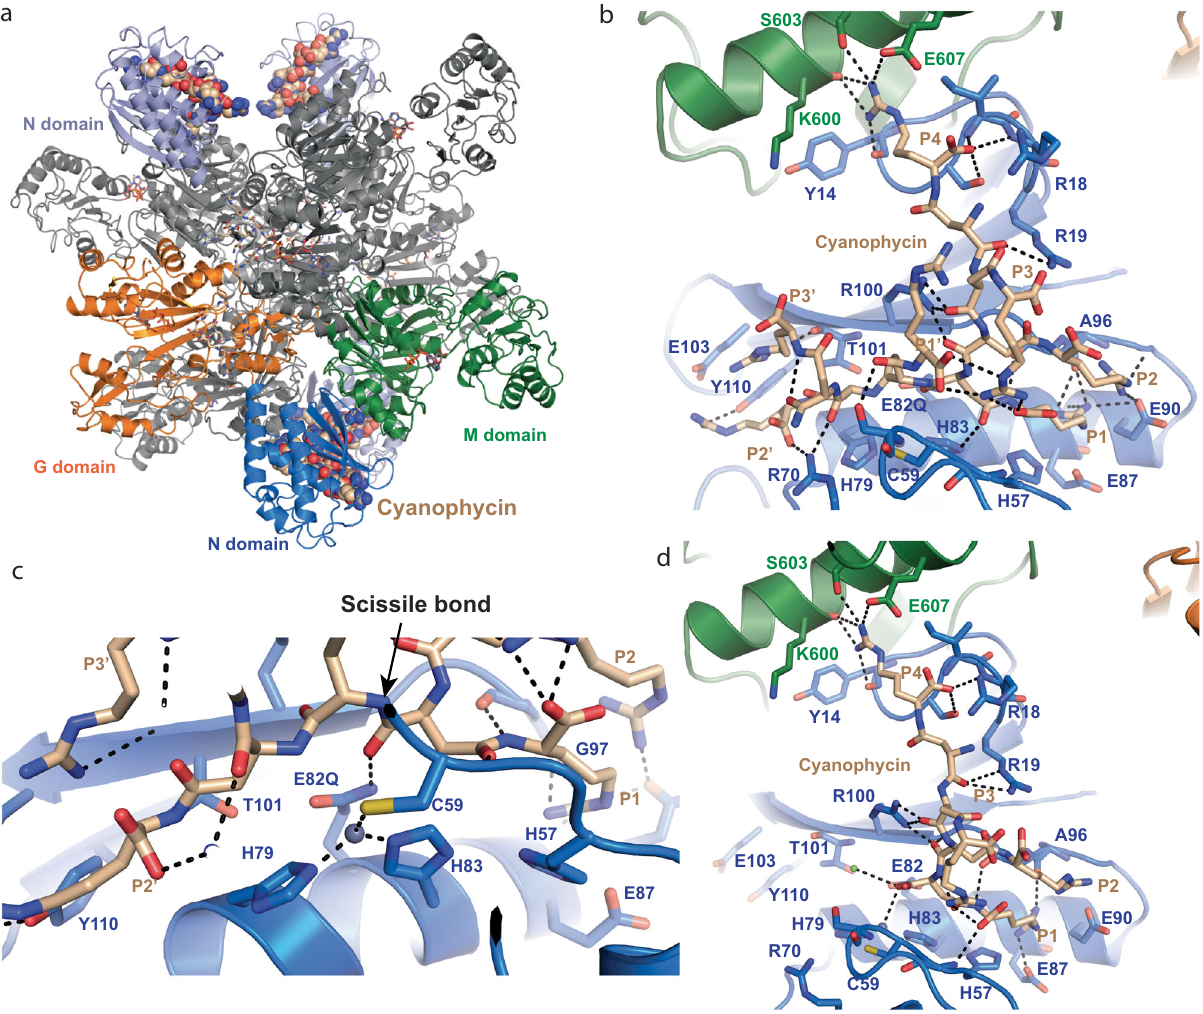
Fig. 3 The structure of SuCphA1 N domain with bound cyanophycin. a Structure of Su CphA1 in complex with cyanophycin substrate in both the G domain active site (sticks) and N domain active site (spheres). b The Su CphA1 N domain in complex with ( β -Asp-Arg) 16 as a substrate. Seven dipeptide residues are visible. Polymer binding residues and their interactions are highlighted. P4, P3, P2, P1, P1 ’ , P2 ’ , P3 ’ denote β -Asp-Arg dipeptides numbered relative to the cleavage point. c Close-up view of the structure of Su CphA1 in complex with cyanophycin substrate. d The structure of Su CphA1 in complex with in situ cleaved cyanophycin. Four dipeptide residues are visible. Polymer binding residues and their interactions are